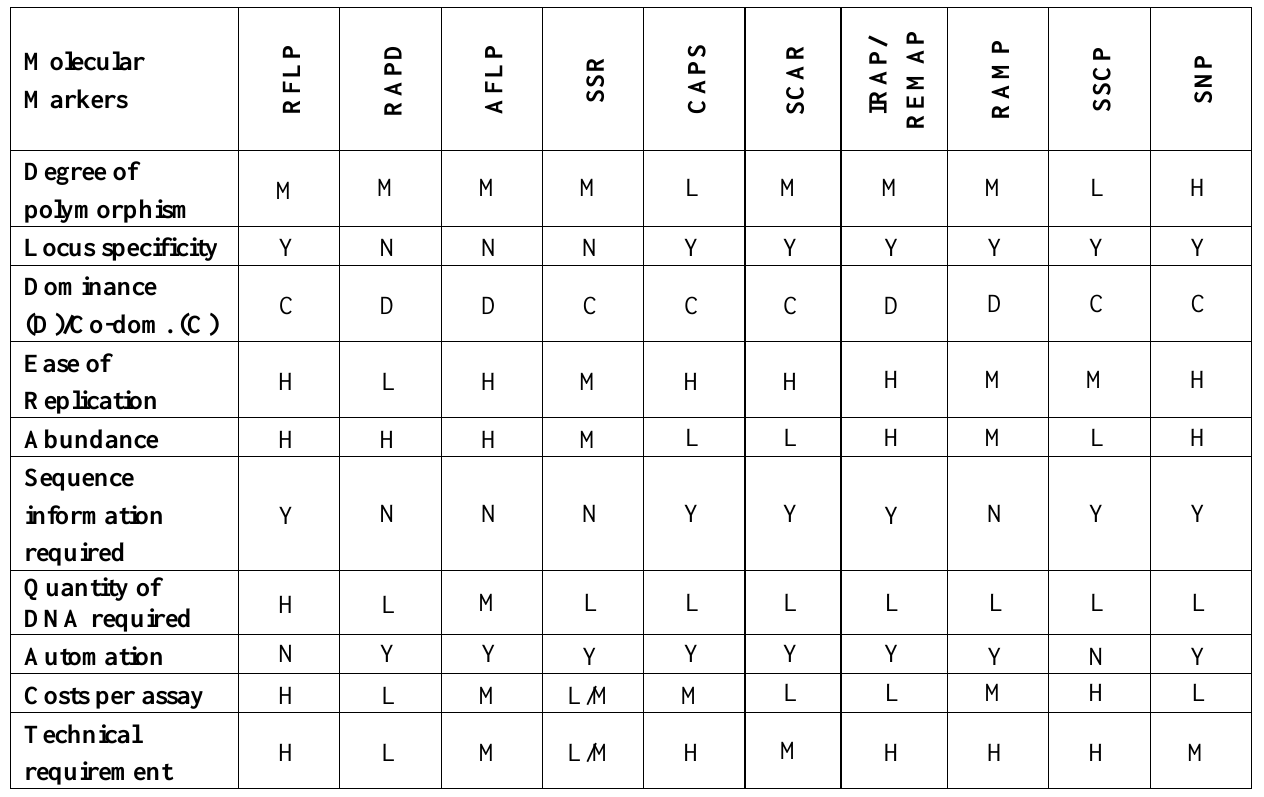
Table 2. Comparison of different characteristics of most frequently used molecular markers